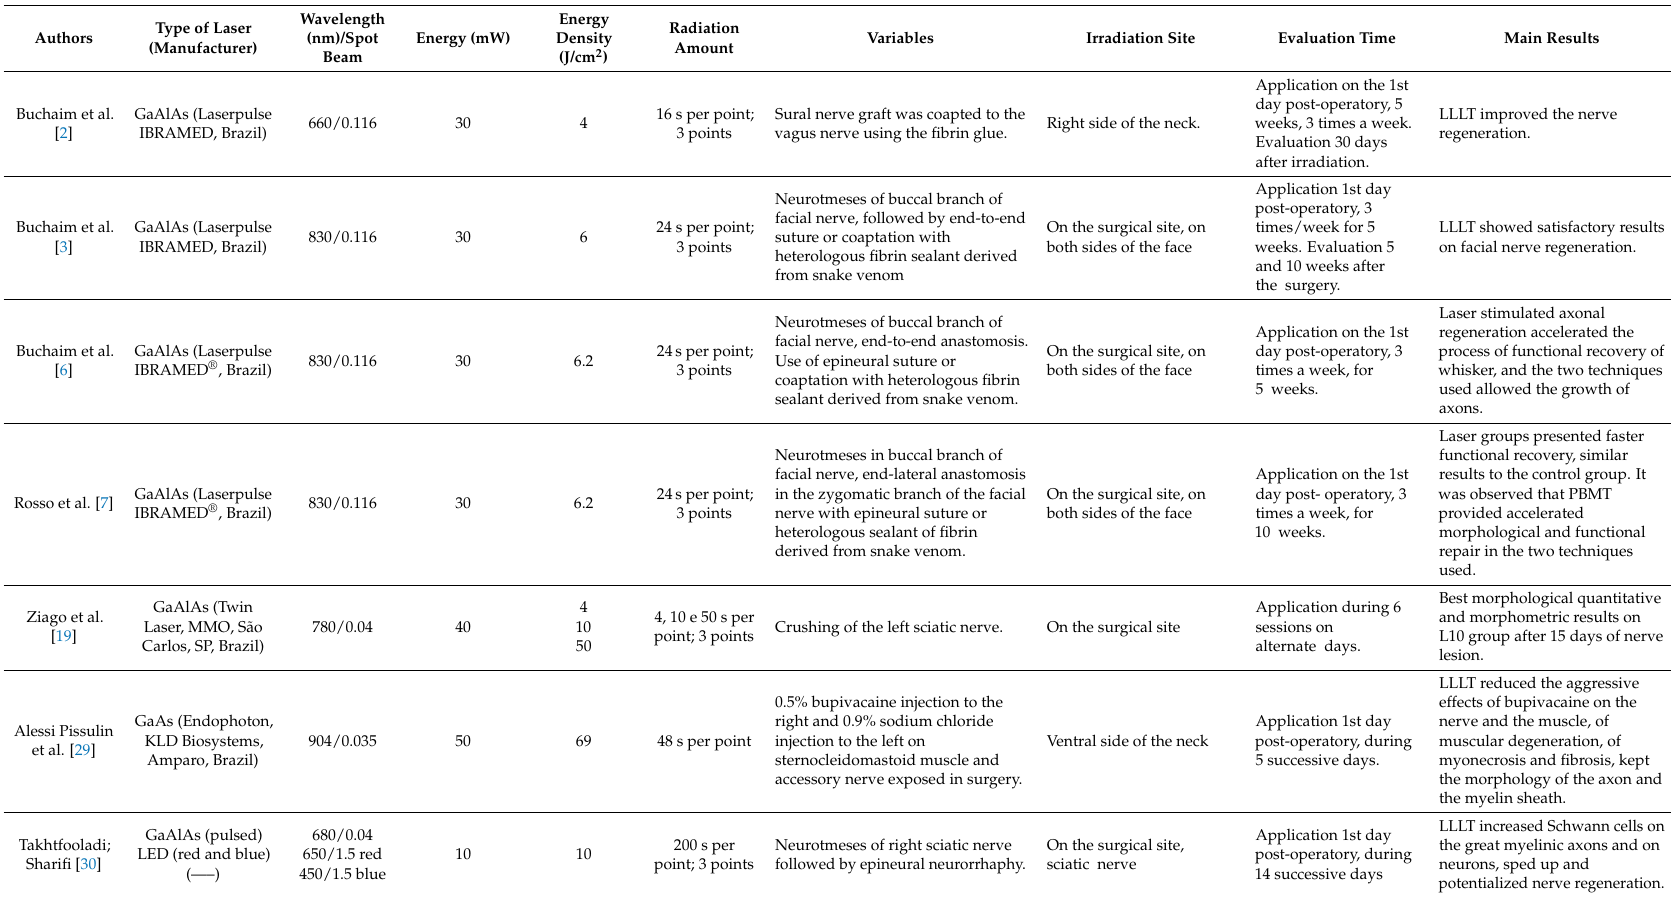
Table 1. Data of selected